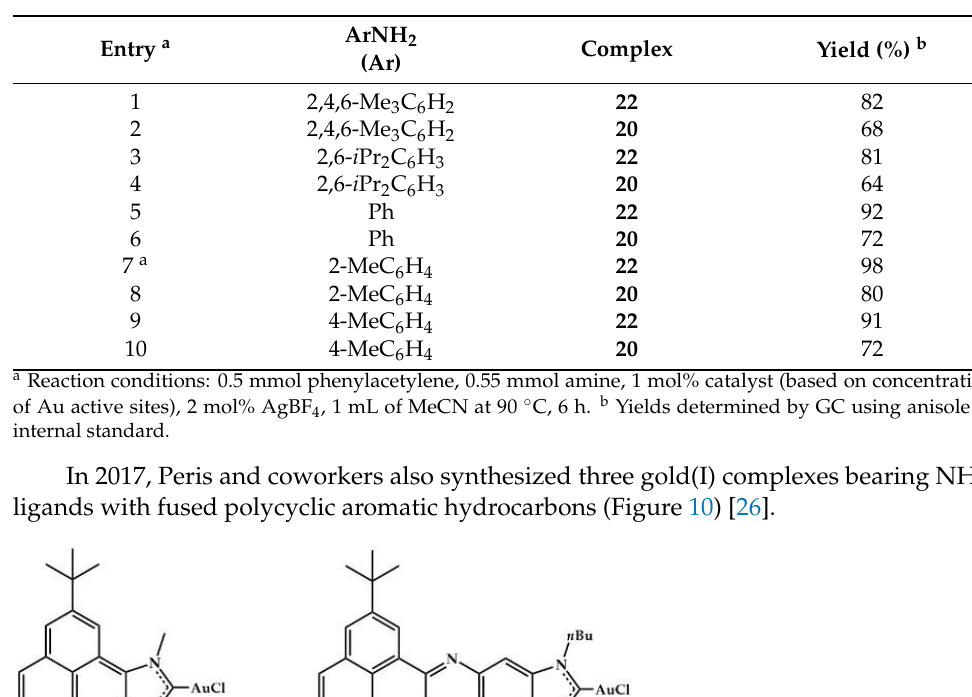
Table 6. Hydroamination of phenylacetylene with substituted anilines.